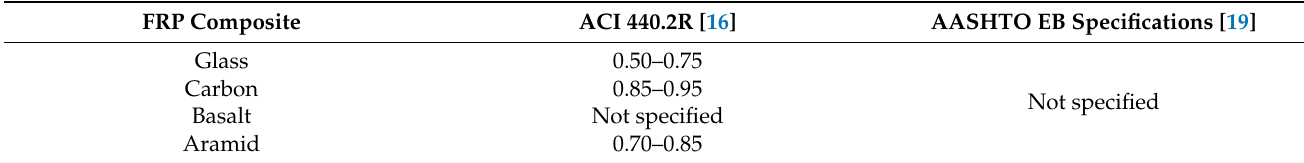
Table 8. Environmental reduction factors on FRP strengthened concrete